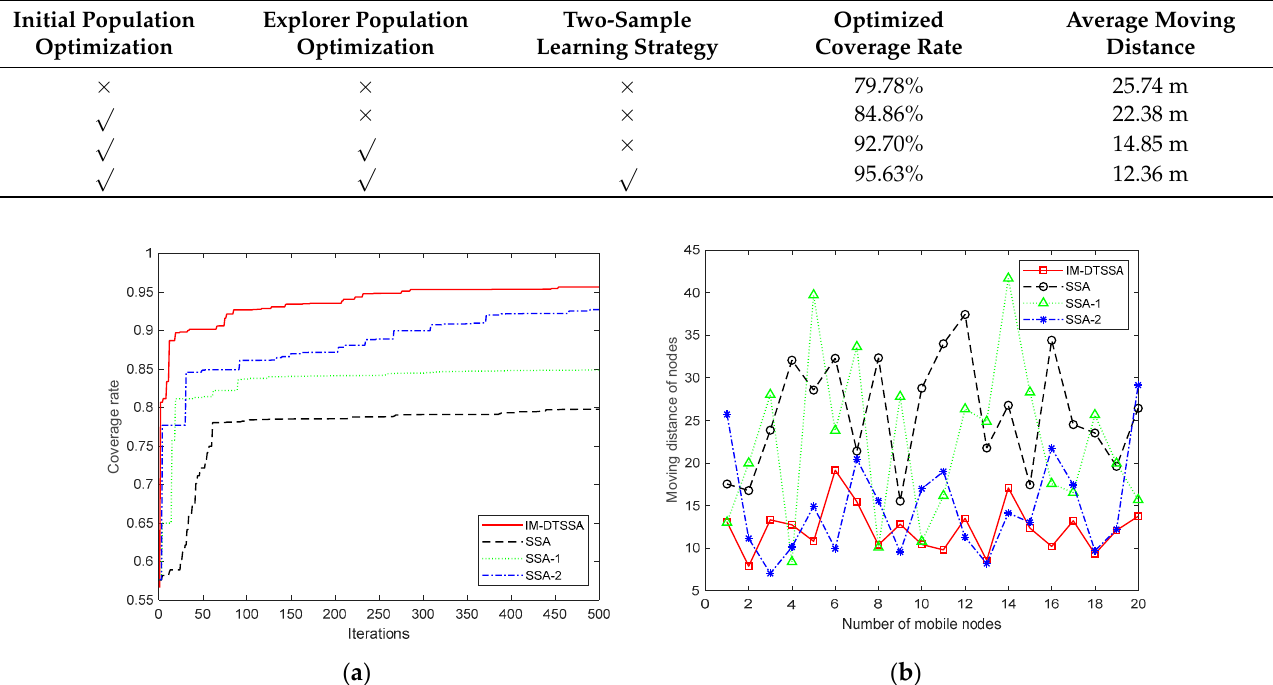
Figure 10. Comparison of the e ff ectiveness of the algorithms.